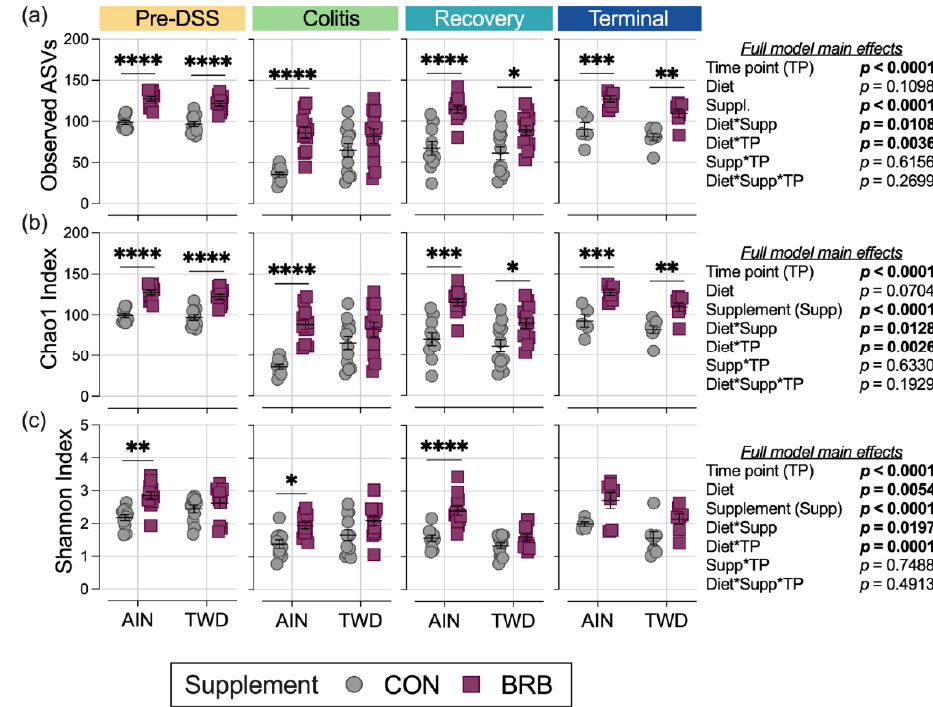
Figure 11. Alpha diversity of mouse fecal microbiomes for each experimental time point (experiment B). Alpha diversity measures include ( a ) observed ASVs, ( b ) the Chao1 index and ( c ) the Shannon index. Data are shown as individual values representing each cage (as the biological unit) with mean ± SE. Inset tables show the statistical model main effects, including all experimental factors, for each α -diversity measure. For simplified visualization, this plot shows only the statistical results for comparisons between CON and BRB-supplemented diets, as indicated: *, p < 0.05; **, p < 0.01; ***, p < 0.001; and ****, p < 0.0001, as outlined in Materials and Methods. Complete results of these statistical analyses, including comparisons within and across time points, are provided in Tables S2–S4.